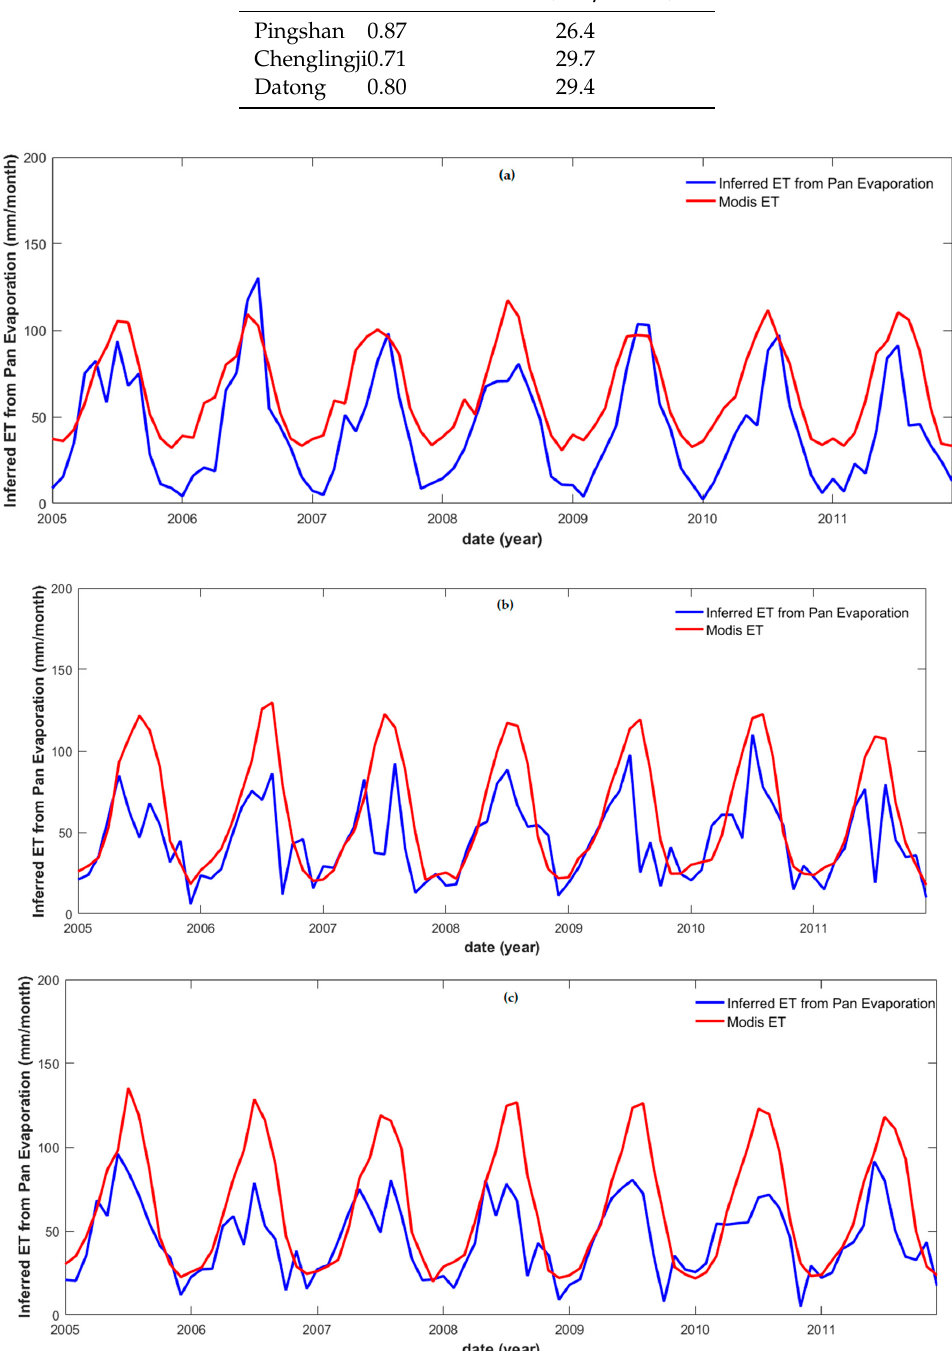
Table 3. Statistical comparison between the remotely sensed MODIS evapotranspiration data and the inferred evapotranspiration from the observed evaporation data at the three selected stations along the upper, middle, and lower reaches of the Yangtze River basin.